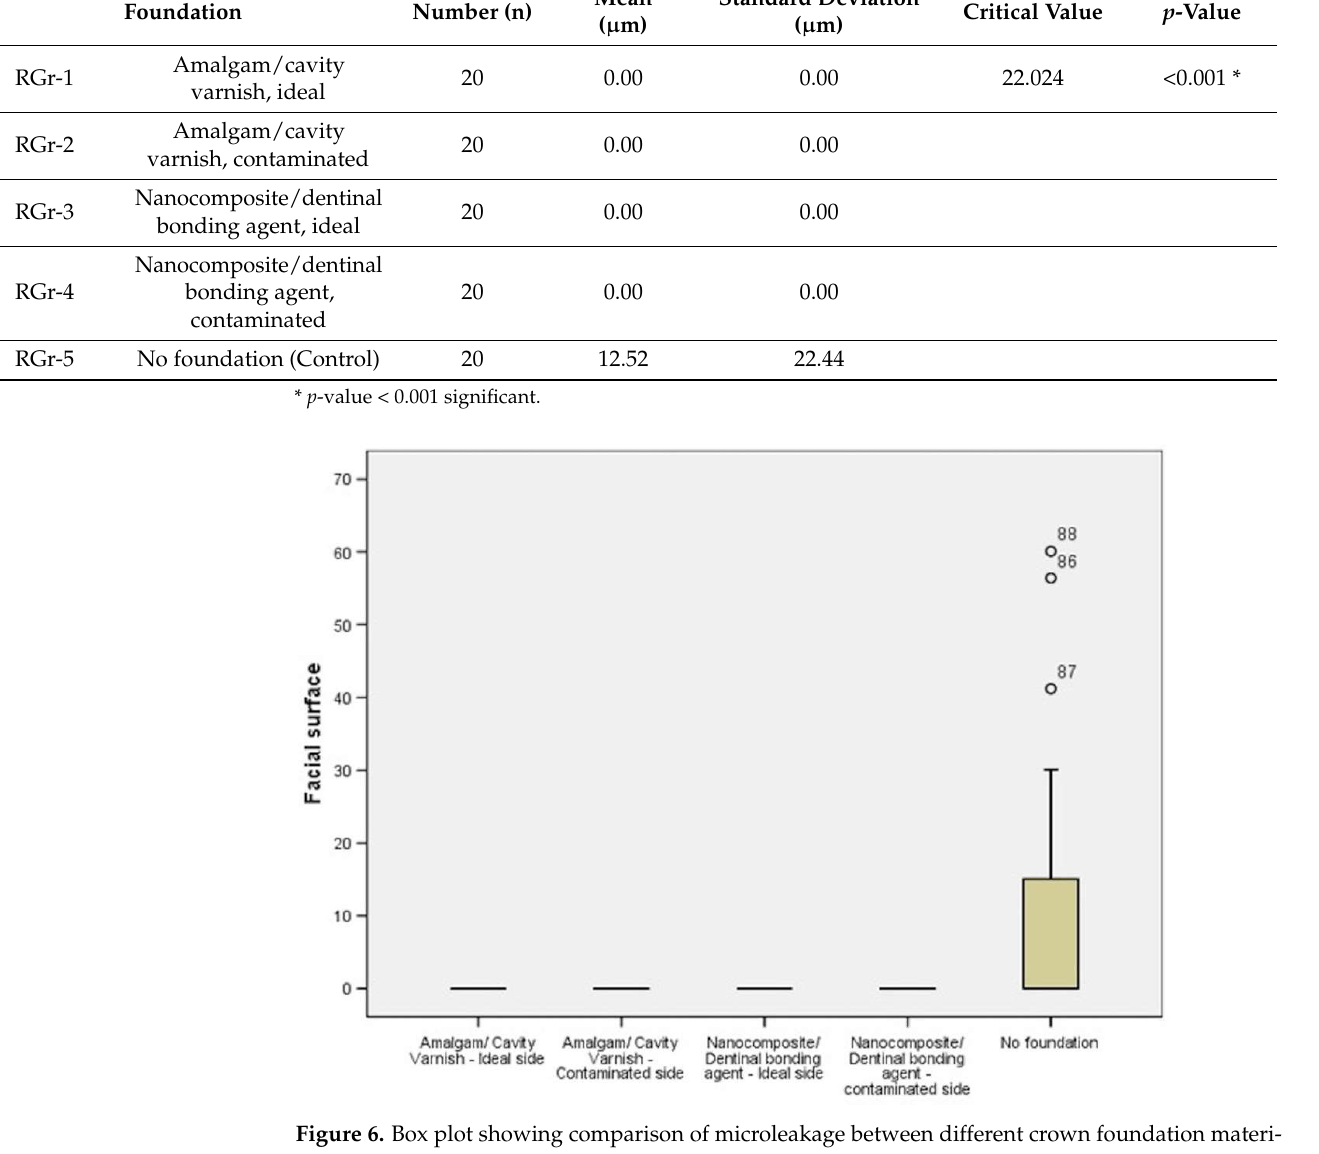
Table 1. Comparison of microleakage between different crown foundation materials on facial surface (n = 20).